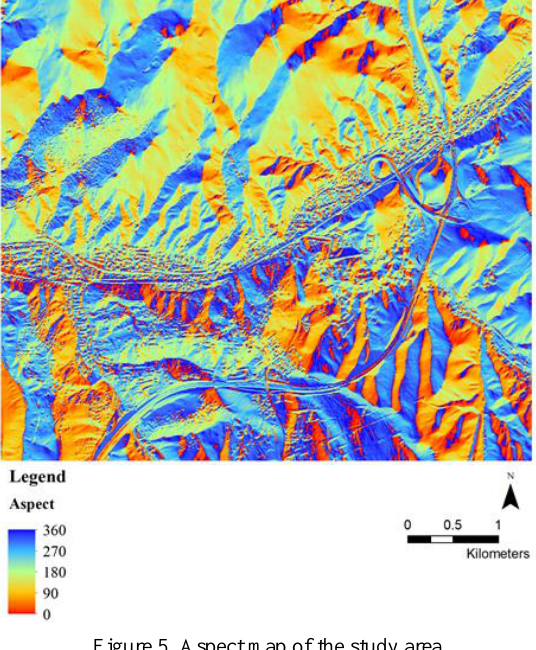
Figure 5. Aspect map of the study area The rate of overall change of the first derivatives (slope gradient and slope direction) of digital elevation models (DEMs) represent the general curvature (Figure 6). The plan and profile curvatures are analyzed separately and corresponding maps are given in Figures 7 and 8.